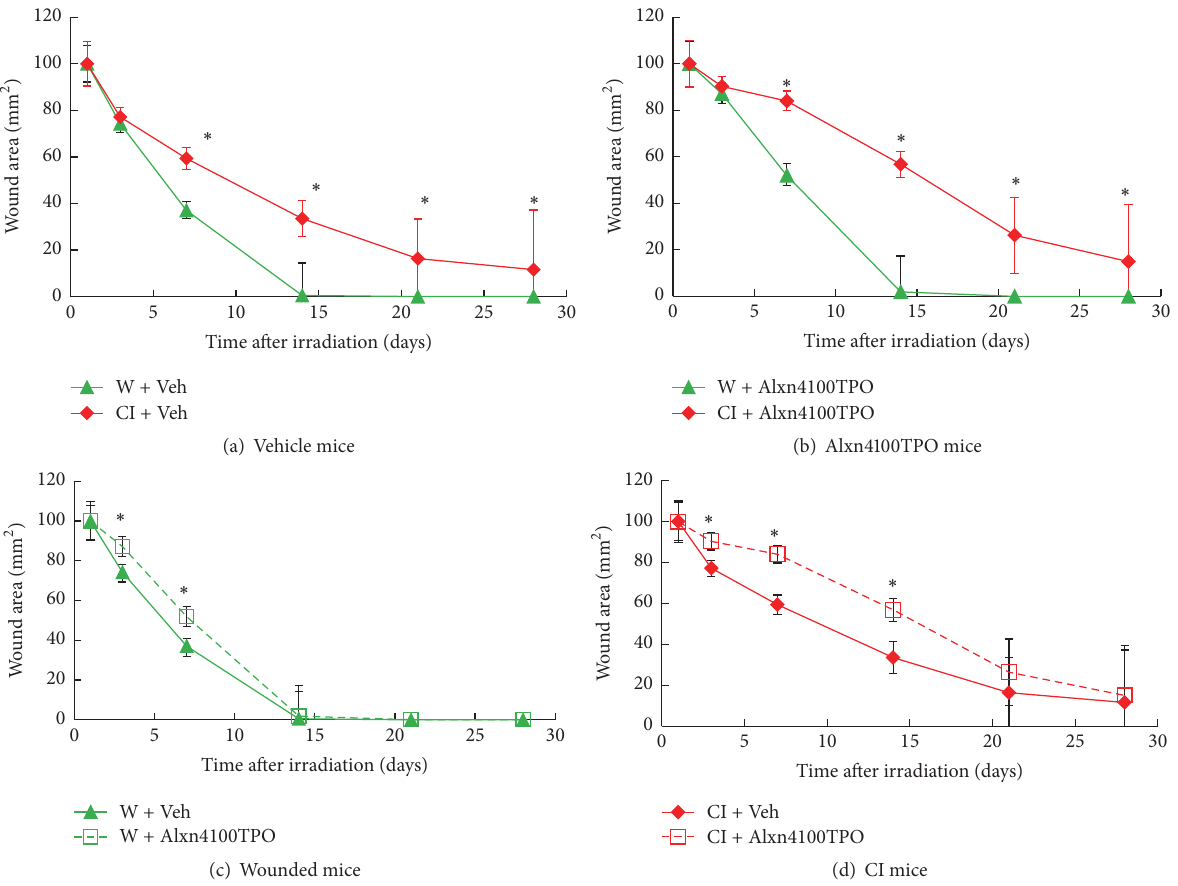
Figure 9: CI delays wound healing, but Alxn4100TPO increased the delay. Wound areas were measured on days 1, 3, 7, 14, 21, and 28. 𝑁 = 19–22 per group. Data are presented as mean ± SEM. For panel (a): ∗ 𝑝 < 0.05 versus RI. For panel (b), ∗ 𝑝 < 0.05 versus W + Alxn4100TPO. For panel (c): ∗ 𝑝 < 0.05 versus RI + Vehicle. For panel (d): ∗ 𝑝 < 0.05 versus CI + Vehicle. Veh: vehicle; W: wound; RI: 9.5 Gy; CI: 9.5 Gy and skin